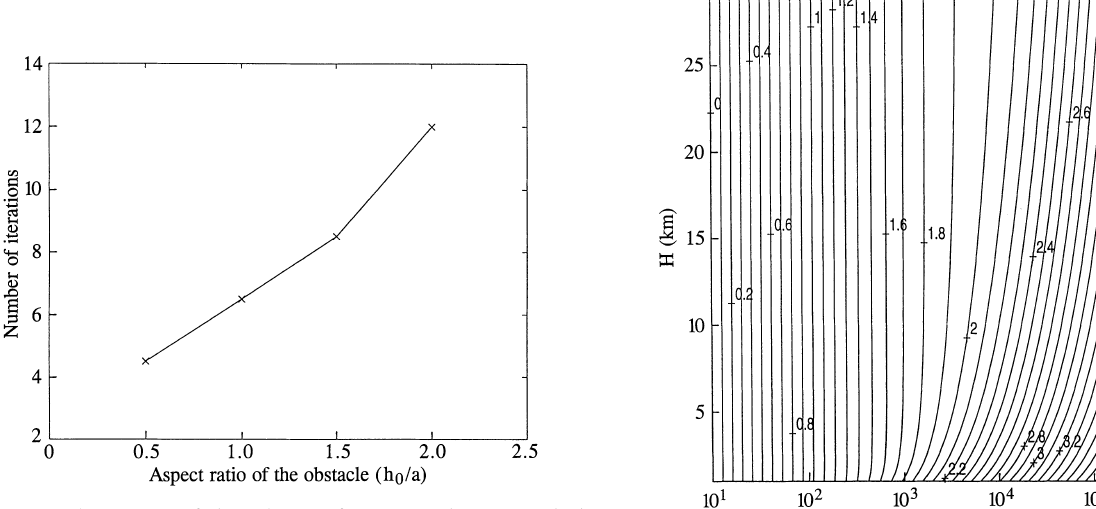
Fig. 6. A measure of the solver performance. The case-study is a simulation of 2D mountain waves. The number of solver iterations needed to achieve a divergence of 10 (cid:255) 10 s (cid:255) 1 is shown as function of the mountain aspect ratio